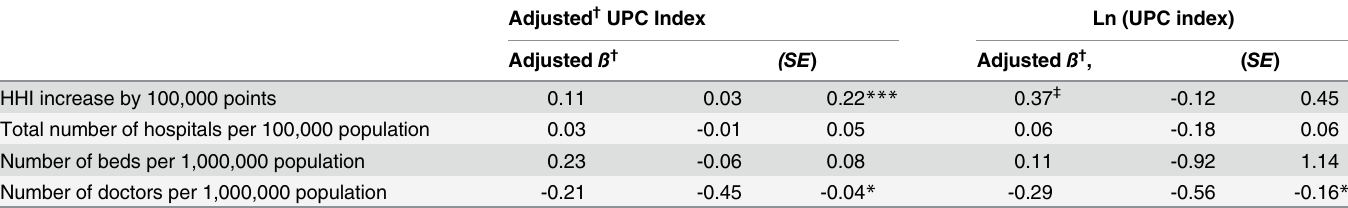
Table 3. Multilevel regression analysis: the associations between HHI and UPC scores (N =